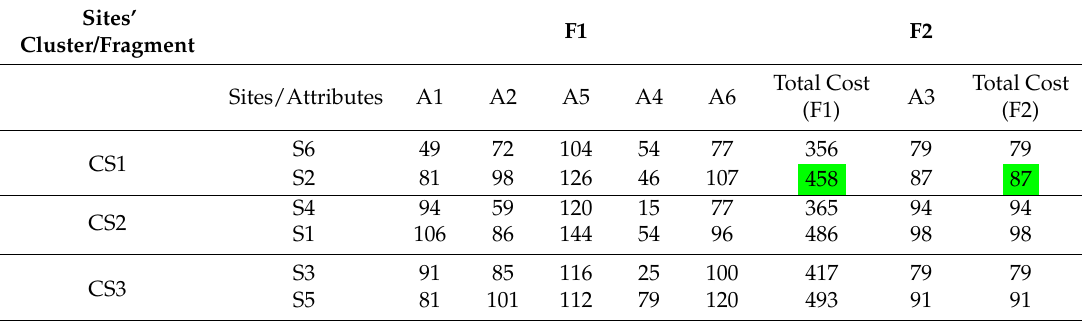
Table 19. Decision allocation matrix of this work.